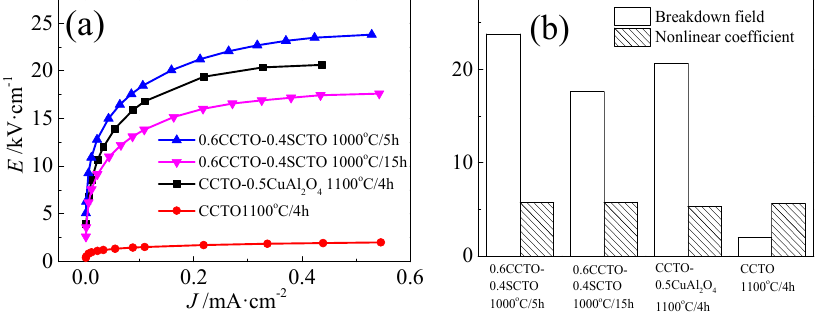
Figure 3. J-E plots ( a ) and breakdown field, nonlinear coefficient ( b ) of CCTO, CCTO-0.5CuAl 2 O 4 , and 0.4SCTO-0.6CCTO ceramics.